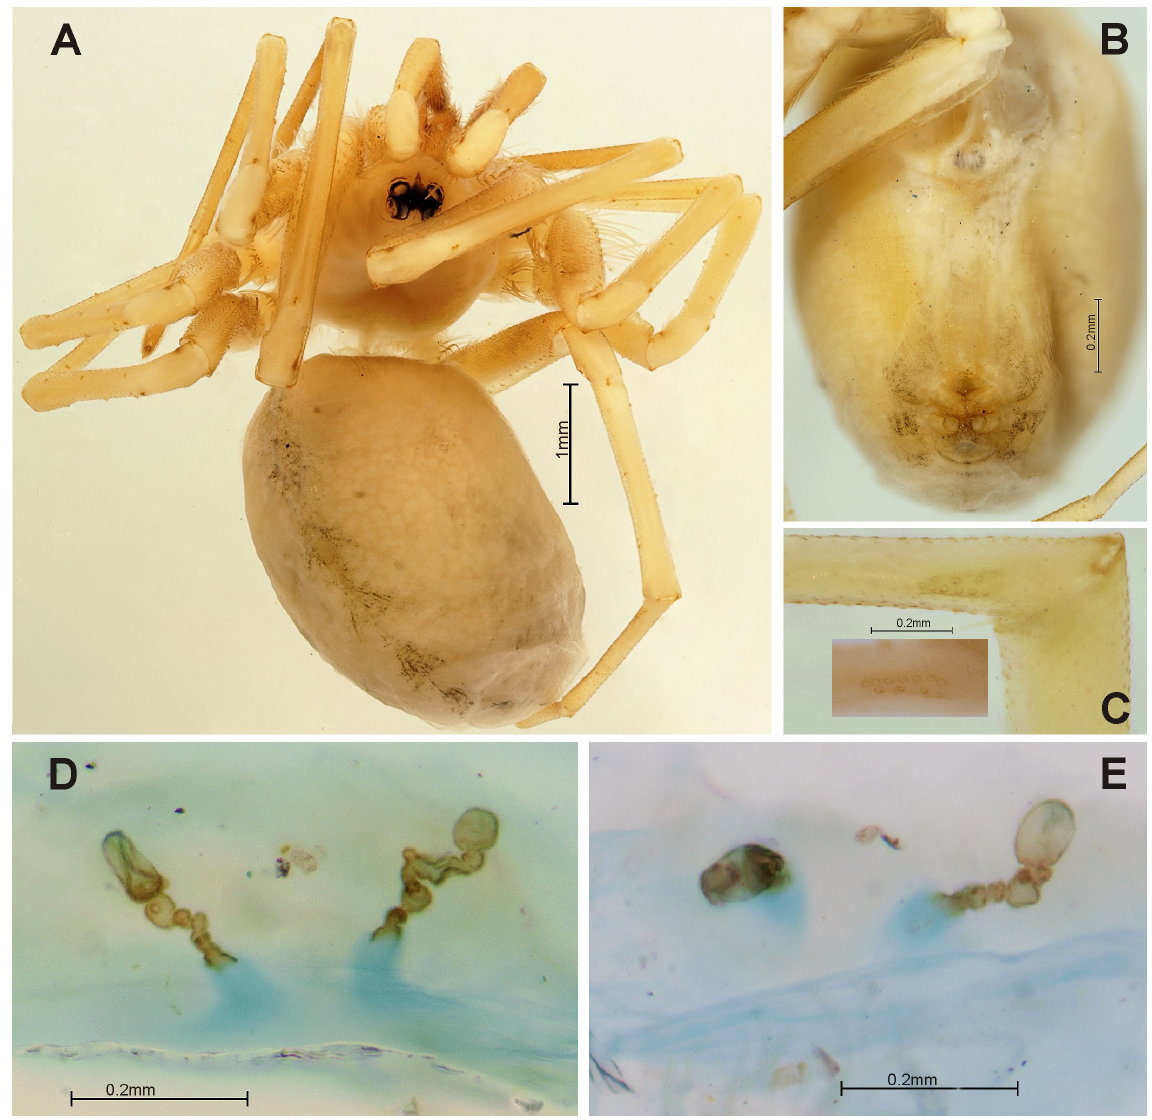
Fig. 45. Somatic characters and endogyne of Pholcoides monticola comb. nov., ♀ from Andarbag. A . Habitus, dorsal. B . abdomen, ventral. C . Calamistrum of both metatarsi iV, all setae lost. D . endogyne, dorsal. E . Same, anterior. Scale bars: a = 1.0 mm; B–e = 0.2